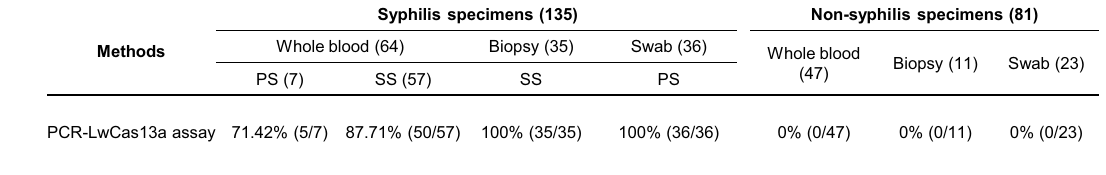
Performance of PCR-LwCas13a assay and TaqMan PCR in clinical specimens with known infectious status